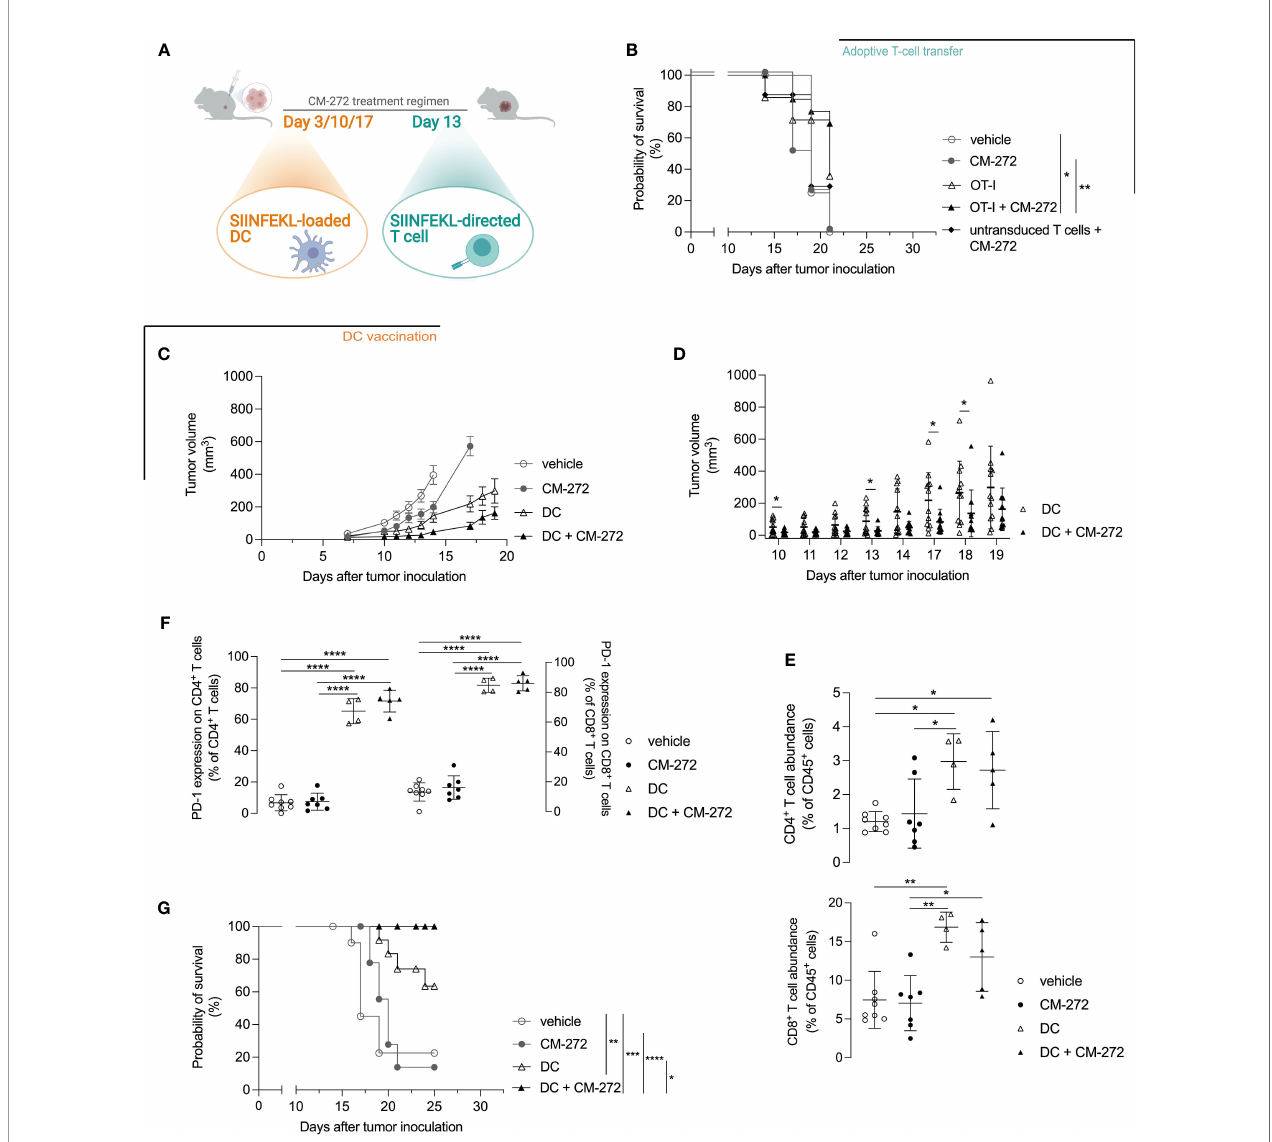
FIGURE 5 | DC vaccination best cooperates with dual G9a and DNMT inhibition in prolonging mouse survival. (A – G) CM-272 combination therapy with (B) adoptive T-cell therapy ( n = 3, total 7-14 m.p.c.) or (C – G) DC vaccination ( n = 2, total 12 m.p.c.). (A) Treatment regimen. (B, G) Survival (Kaplan-Meier curve) upon CM-272 combination with (B) T-cell therapy or (G) DC vaccination. (C, D) Tumor volume in time (mean ± SEM [C]/mean ± SD [D]). (E, F) Tumor-contexture upon CM-272 combination with DC vaccination ( n = 1, 4-8 m.p.c.). (E) CD4 + /CD8 + T-cell abundance. (F) PD-1 expression on CD4 + /CD8 + T cells. Vehicle and experimental conditions were compared using Log-rank test (B,G); REML modeling with Geisser-Greenhouse correction and post-hoc Sidak multiple comparison test (C) ; unpaired one-tailed student t -test or Mann-Whitney test (D) ; ordinary one-way Anova and post-hoc Tukey ’ s multiple comparison test (E, F) . Asterisks indicate statistical signi fi cance: *p ≤ 0.05; **p ≤ 0.01; ***p ≤ 0.001; ****p ≤ 0.0001. Statistical signi fi cance of panel C is supplemented in Table S4